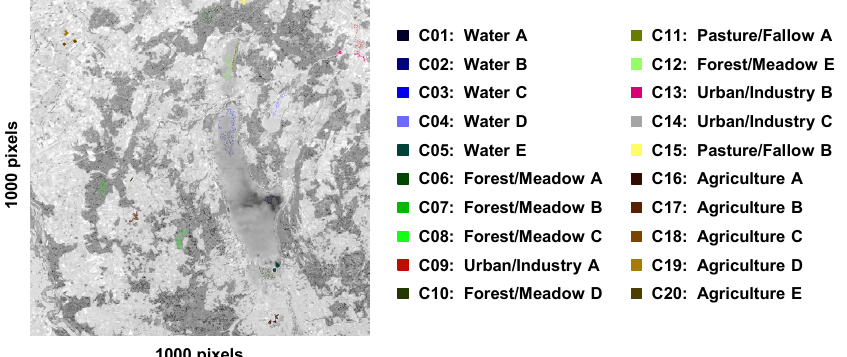
Figure 4. Reference labels for the EnMAP dataset [1]: each pixel is characterized by reflectance values on 244 spectral bands. The few labeled pixels are indicated in different colors, while a gray-scale visualization of the scene is given for the unlabeled